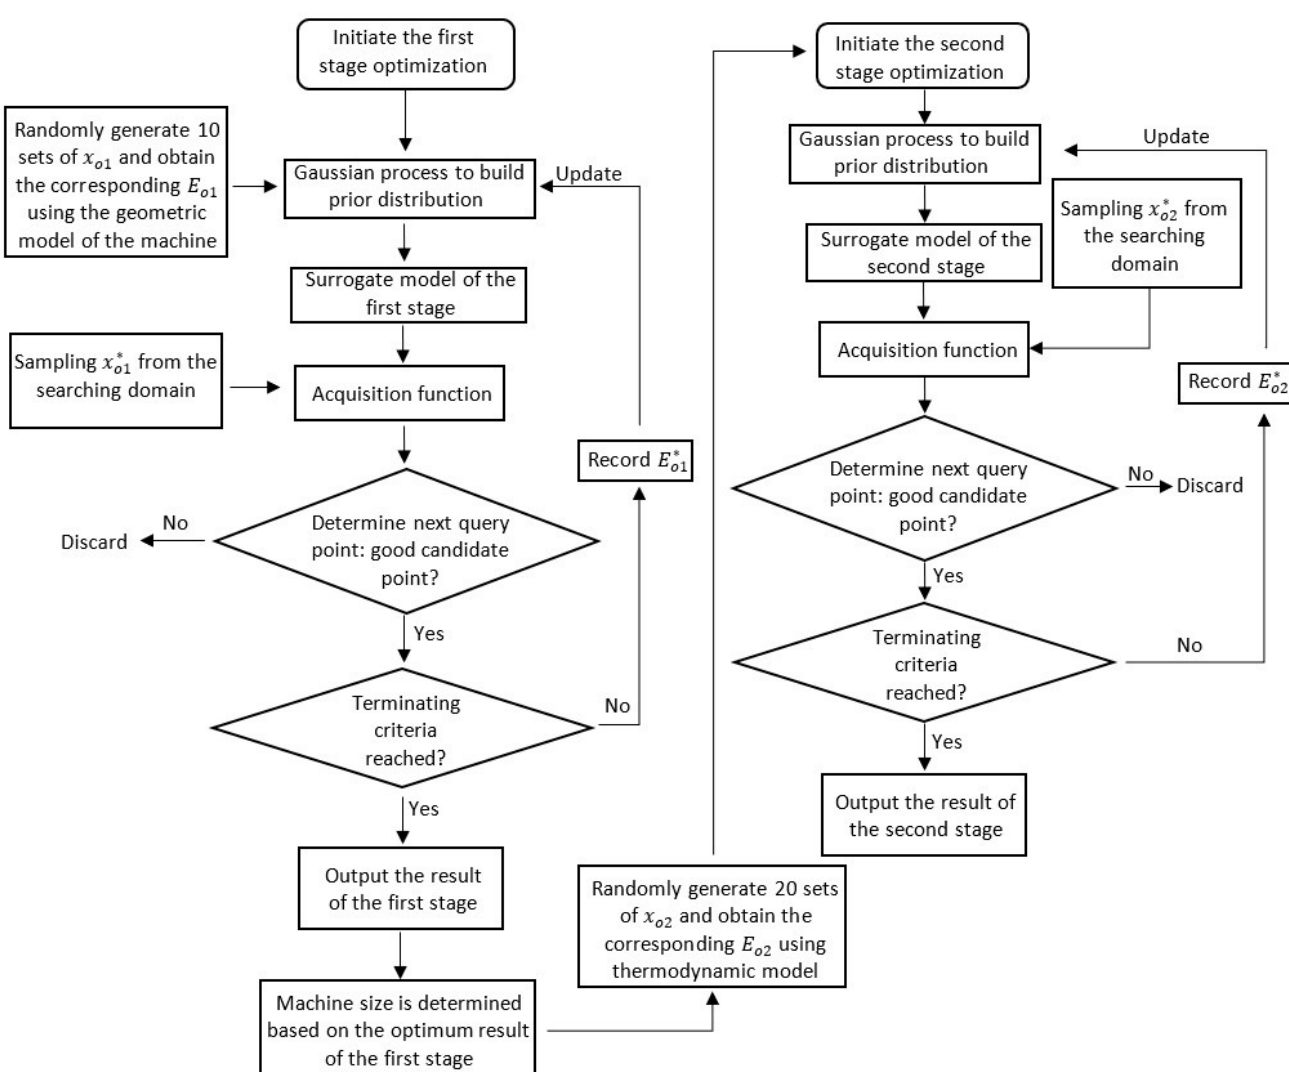
Figure 4. Illustration of the two-stage optimization process.